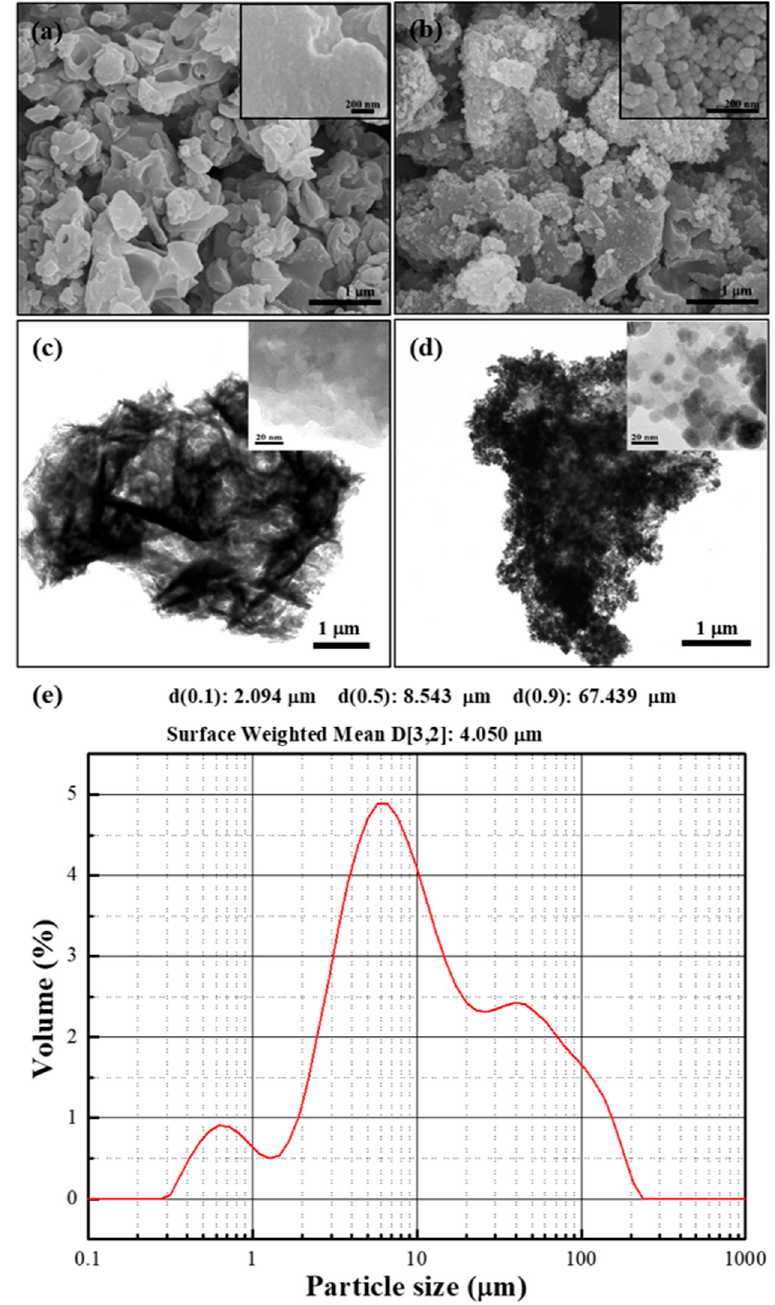
Figure 1. ( a , b ) SEM, ( c , d ) TEM images of PDPA and PDPA / Fe 3 O 4 , and ( e ) particle size distribution of PDPA. (The inset shows partial enlargement).